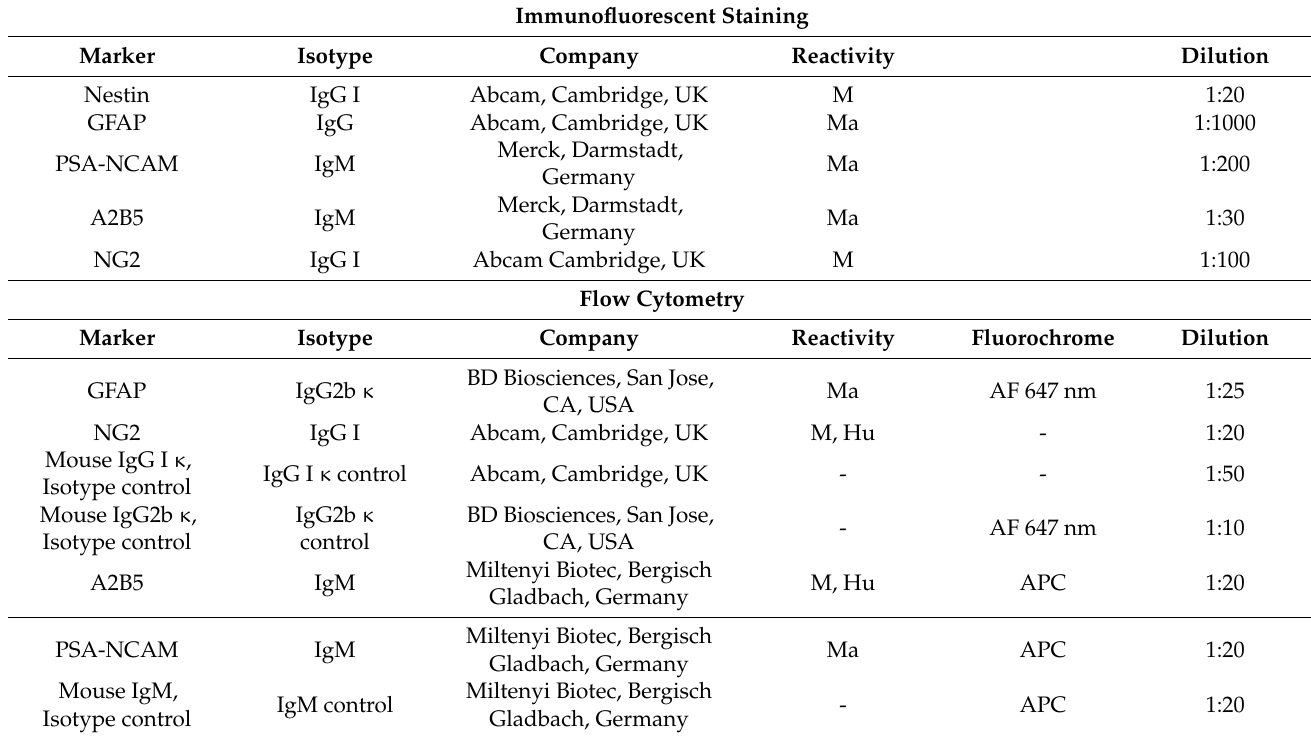
Table 1. Antibody